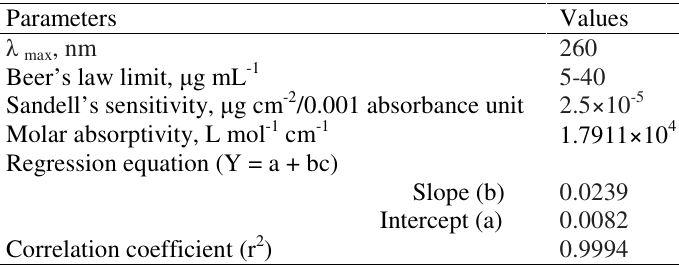
Table 1. Optical characteristics of proposed method.